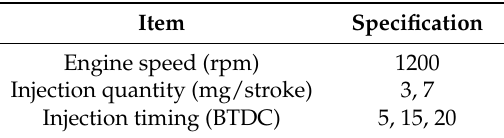
Table 6. Engine combustion test conditions.